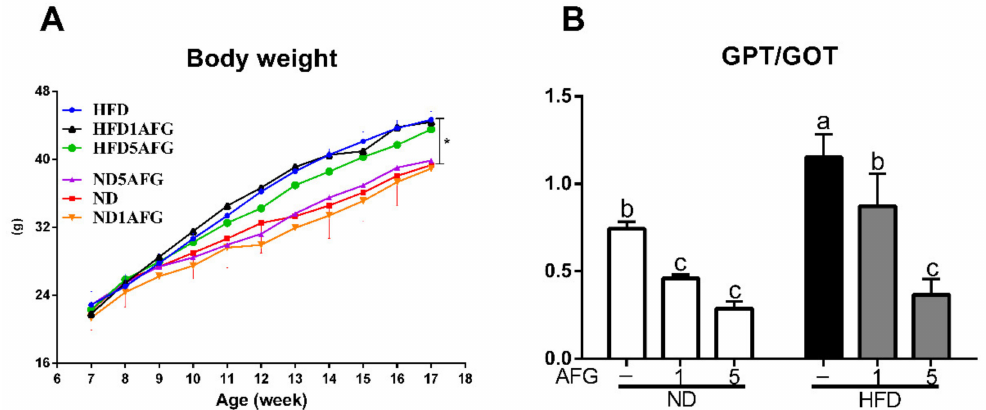
Figure 1. Body weight and index of liver injury. ( A ) The changes in body weight of mice fed with di ff erent diets from 7 to 18 weeks. Results are expressed as the mean ± SD for each group of mice (n = 4). The asterisk indicates a significant di ff erence in weight at 18 weeks ( p < 0.05). HFD: high-fat diet, HFD1AFG: HFD plus 1% AFG, HFD5AFG: HFD plus 5% AFG, ND: normal diet, ND1AFG: ND plus 1% AFG, ND5AFG: ND plus 5% AFG. ( B ) The ratio of serum GPT / GOT. The data represent the mean ± SD of four mice. The di ff erent letter indicates a significant di ff erence at p <